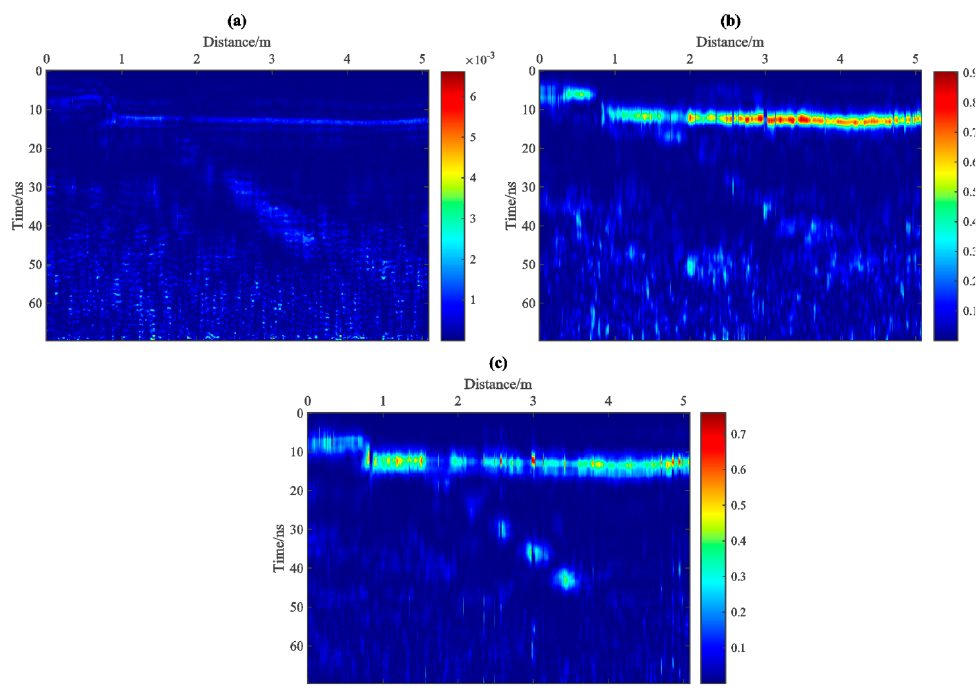
Figure 17. IMF-slices of the field data using VMD. ( a − c ) show the IMF-slices 1 − 3, respectively.